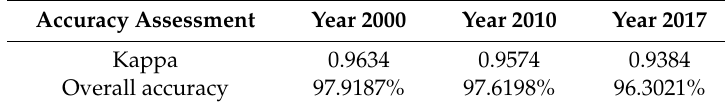
Table 5. Accuracy assessment for the produced maps.